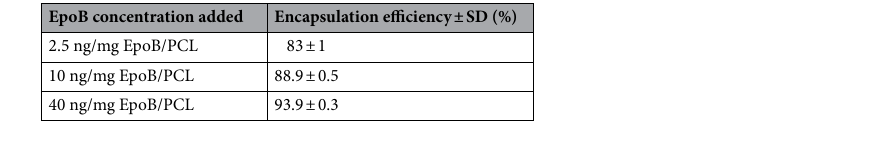
Table 7. Encapsulation efficiencies for different drug loading. Sample size n = 3, P < 0.001.